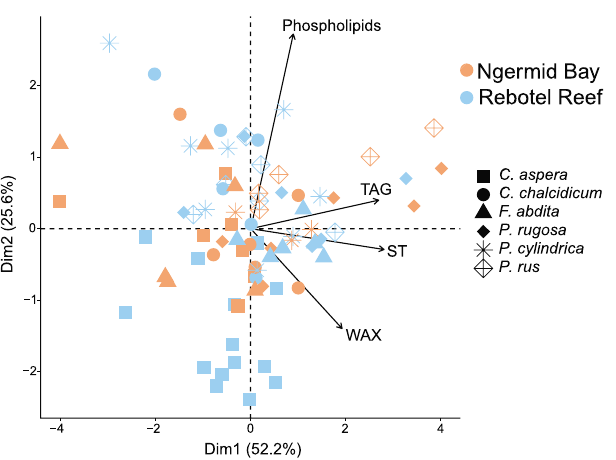
Figure 5. Principal component analysis (PCA) of lipid class composition for C. aspera (square), C. chalcidicum (circle), F. abdita (triangle), P. rugosa (solid diamond), P. cylindrica (six-pointed asterisk), and P. rus (open diamond with plus sign) from nearshore (Ngermid Bay; orange) and offshore (Rebotel Reef; blue). Vectors represent direction and strength of the contribution of biomass measurements to sample distribution with Dim1 and Dim2 explaining 52.2% and 25.6%, respectively, of sample variance. All corresponding Kruskal–Wallis test and two-way ANOVA results, comparing a variable across site and species, are in Table 1, with post-hoc